Question: Name the type of graph shown.
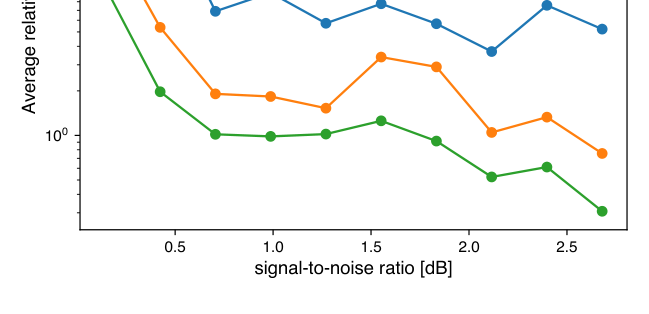
Answer: line